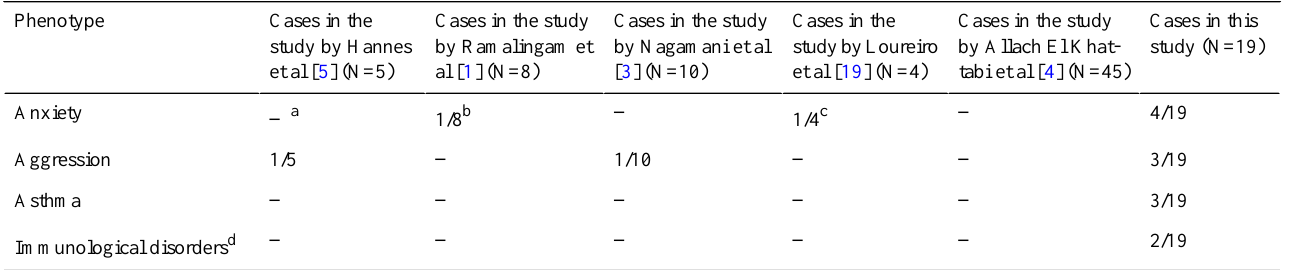
Table 3. Comparison of the self-phenotyping cohort with published case reports for anxiety, aggression, asthma, and immunological disorder phenotypes.